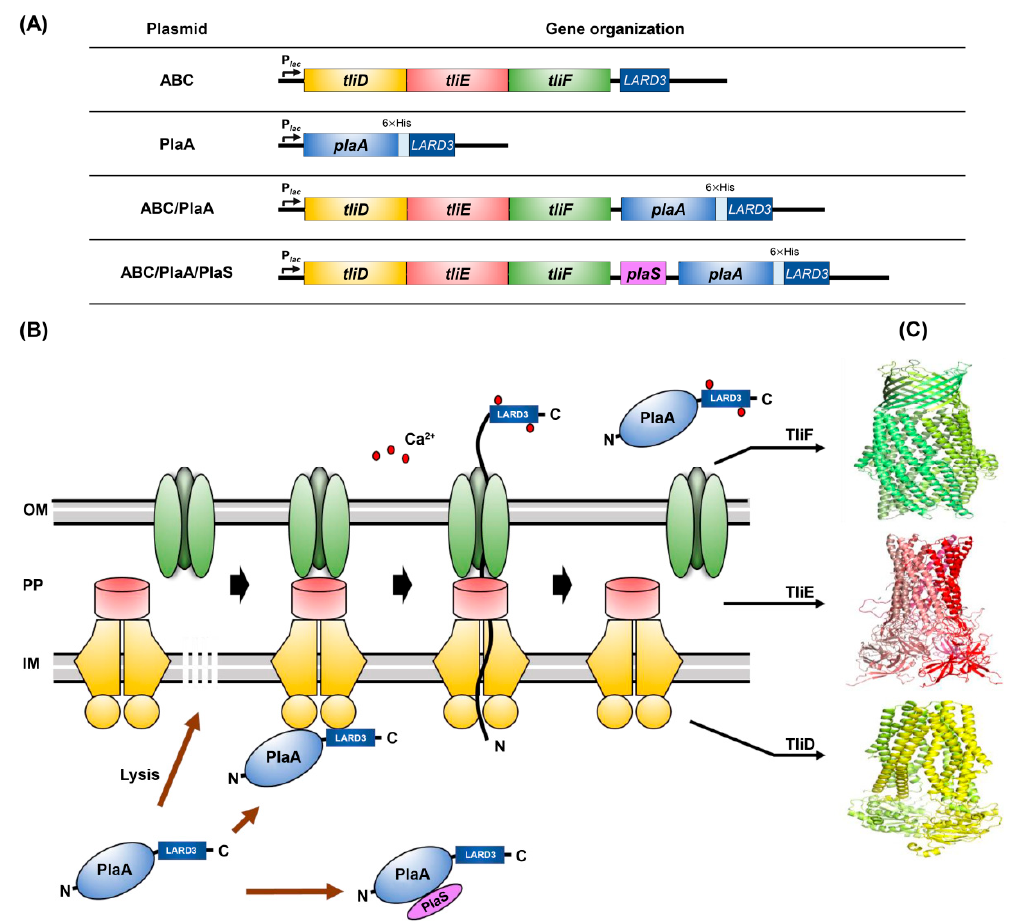
Figure 1. Construction of recombinant plasmids and the scheme of bacterial phospholipase A (PlaA) secretion by ABC transporter in P. fluorescens ZYAI. ( A ) Recombinant plasmids were constructed by incorporating plaA and plaS into pDART. All genes were under the control of the E. coli lac promoter. Each original ribosomal binding site is placed at the upstream positions of plaA and plaS . ABC: pDART; PlaA: pPlaA; ABC/PlaA: pDART-PlaA; ABC/PlaA/PlaS: pDART-PlaA/PlaS. ( B ) Schematic representation of PLA1 secretion by ABC transporter. The TliDEF are separated in the resting state. When the C-terminal of ABC transporter recognition domain 3 (LARD3) binds to TliD, the ABC transporter assembles. The PlaA is secreted into the extracellular medium through the ABC transporter. The extracellular calcium ions attach to certain parts of the signal sequence and pull the remaining protein out of the cell. If the PlaA is accumulated in the cell, it induces cell lysis. The PlaS reduces PlaA secretion with interaction of PlaA. ( C ) The three-dimenional (3D) structures of the TliDEF. The structures of dimeric TliD, hexameric TliE, and trimeric TliF were predicted by SWISS-MODEL. OM: outer membrane; PP: periplasm; IM: inner membrane.